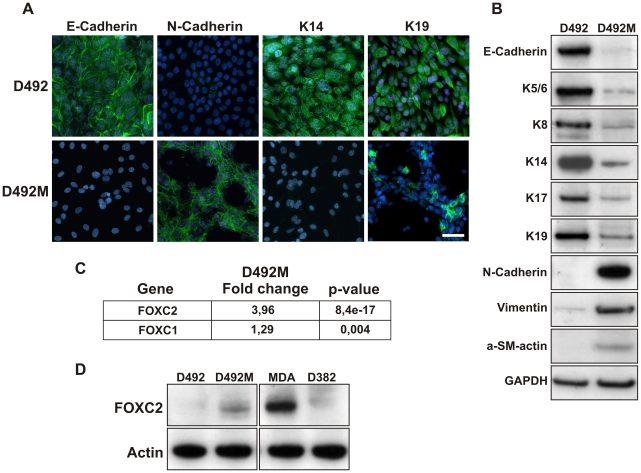
D492M has acquired an EMT phenotype.
A, Immunofluoresence staining on D492M show switch from E- to N-Cad and reduced expression of K14 and K19. Counterstain TO-PRO-3, Bar 100 µm. B, Western blotting confirms downregulation of epithelial markers such as E-Cad, K-5/6, 8, 14, 17 and 19 in D492M. In contrast, the mesenchymal markers N-Cad, Vimentin and alpha-smooth muscle actin were expressed more intensively in D492M than D492. GAPDH loading control. C, EMT associated transcription factors are upregulated in D492M. Gene expression data showed upregulation of FOXC2 (3.96 fold,p: 8.4e-17) and FOXC1 (1.29 fold,p: 0.004) transcription factors in D492M. D, FOXC2 is strongly expressed in breast epithelial cell lines with EMT phenotype. Western blotting shows strong expression of FOXC2 in D492M and MDA-MB-231, an EMT-like breast cancer cell line, compared to no or low expression in D492 and D382. Actin, loading control.